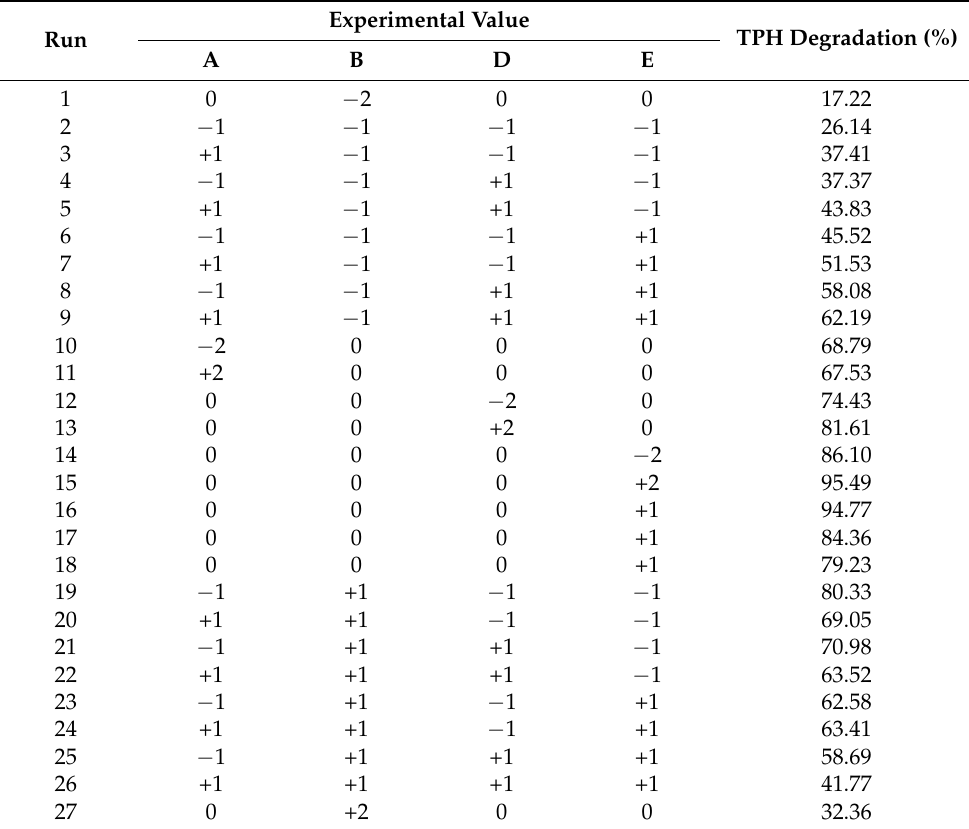
Table 4. Central composite design (CCD) permutation matrix for the screening of significant factors and the corresponding TPH degradation efficiency by consortium